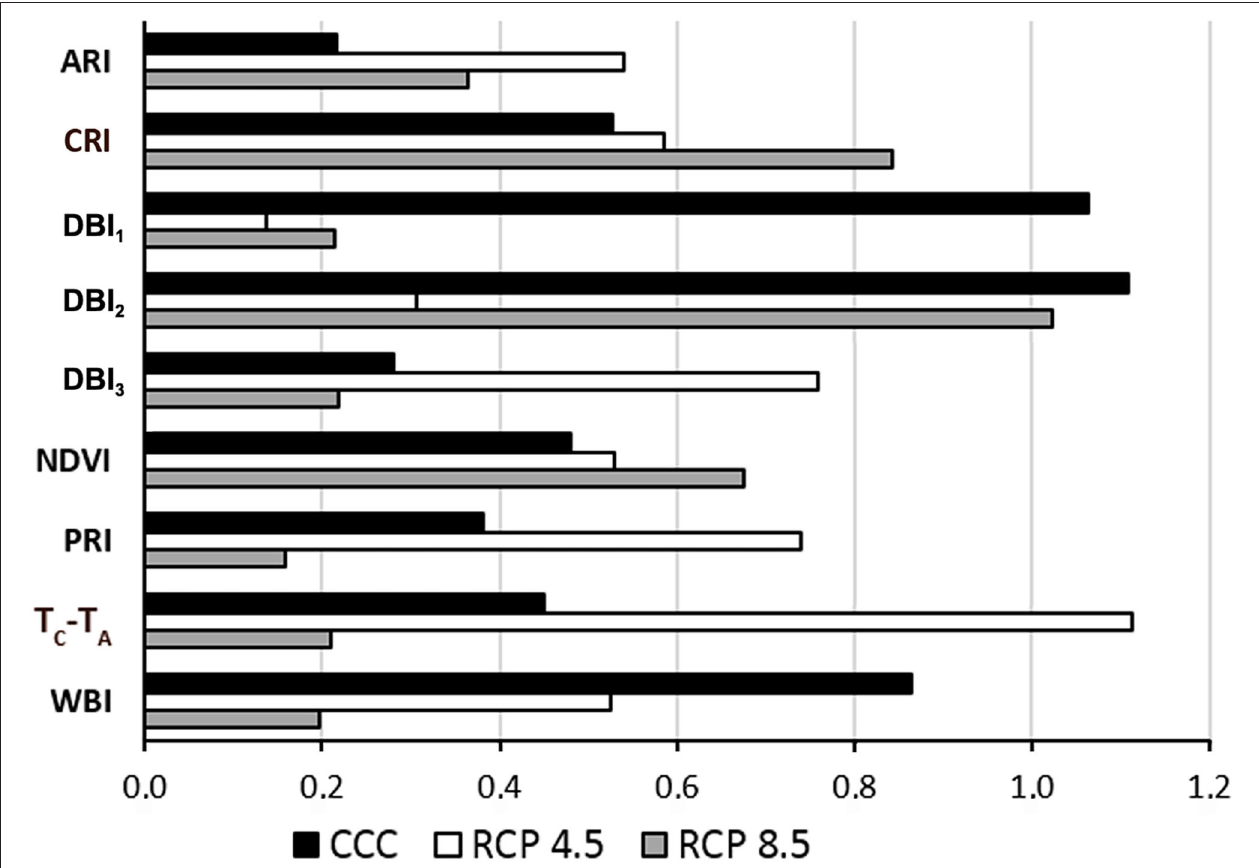
FIGURE 4 | Global variable importance calculated using a global surrogate random forest (RF) model. CCC, current climate conditions; RCP 4.5 and 8.5, representative concentration pathways 4.5 and 8.5; ARI, anthocyanin reflectance index; CRI, carotenoid reflectance index; DBI 1 − 3 , disease broccoli index 1–3; NDVI, normalized difference vegetation index; PRI, photochemical reflectance index; T C -T A , normalized temperature; WBI, water balance